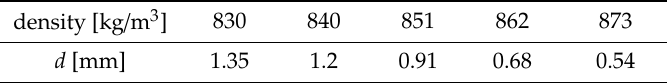
Table 5. Maximum solid particles size for the flow condition.